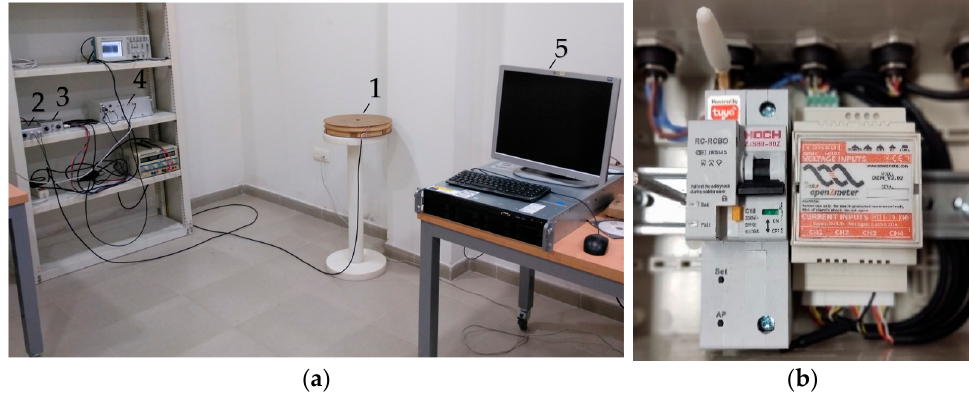
Figure 4. ( a ) System installed in the laboratory of the Research Group: 1. ELF magnetometer; 2. Amplification stage; 3. End amplifier; 4. ADC + DSP; 5. Compute server; ( b ) Front view of the oZm.